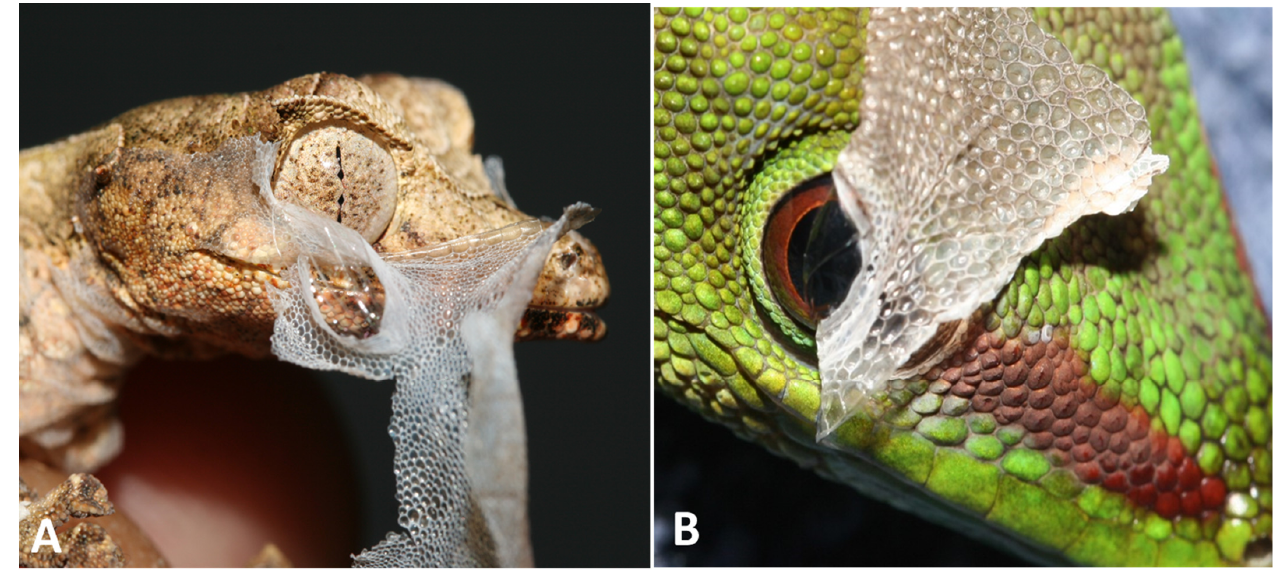
Figure 9. In most spectacled lizards, the renewal of the skin is a more gradual process in comparison with snakes, but the actual sloughing of the skin occurs in a short period of time. The spectacle should always be released together with the shed of the head as seen in ( A ) a satanic leaf-tailed gecko ( Uroplatus phantasticus ) and ( B ) a Madagascar day gecko ( Phelsuma madagascariencis ) . The clinical and histological healing of the spectacle was studied in ball pythons ( Py- thon regius ) [50]. Twenty-four hours after experimental removal of a quadrant of the spec-